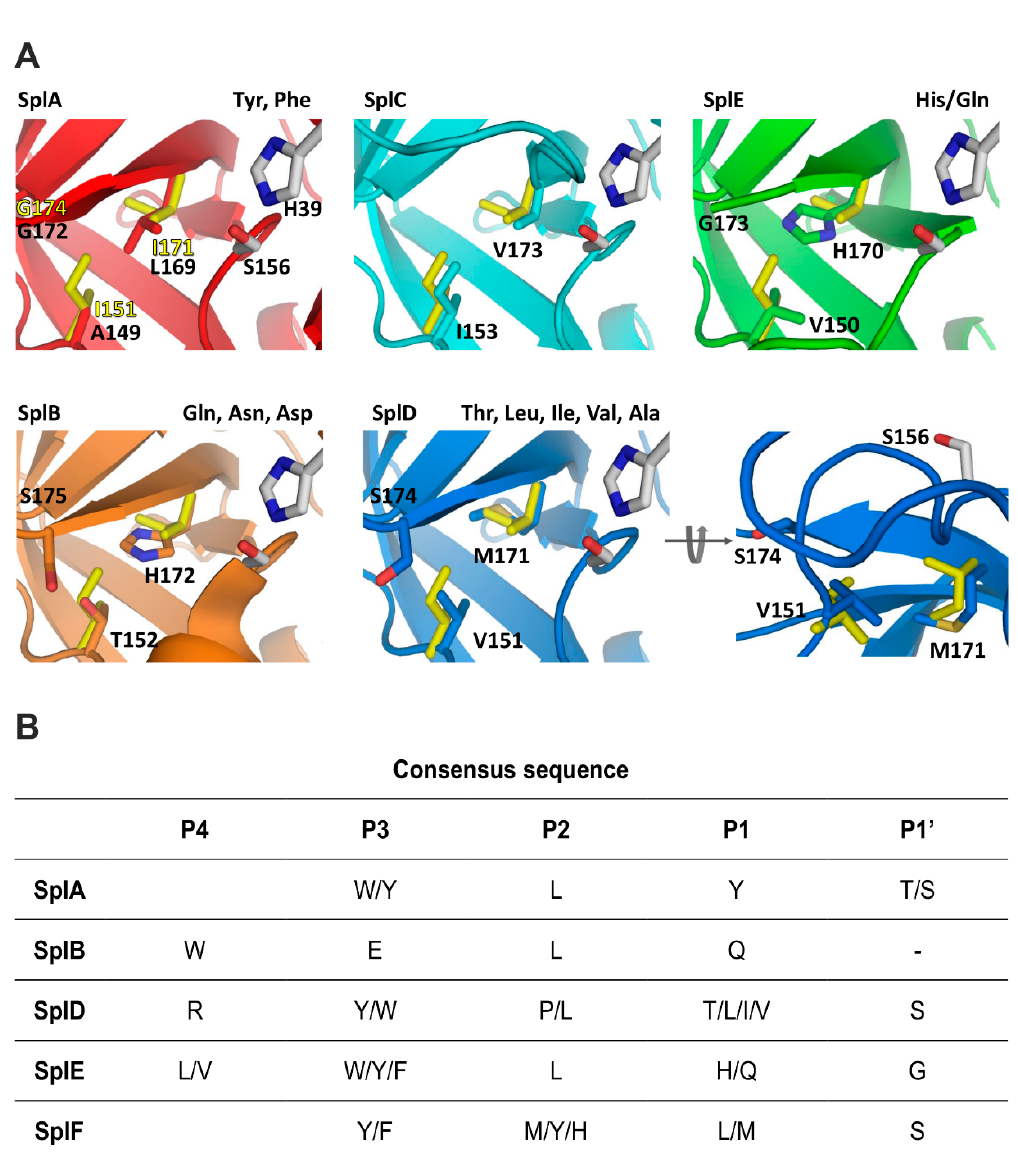
Figure 4. S1 specificity pockets of Spl proteases in the context of their substrate specificities. ( A ) The residues defining the S1 pocket of SplF (PDB 6SF7, yellow) are overlaid on relevant pockets of other proteases of the spl operon: SplA (PDB 2W7S, red) [13], SplB (PDB 2VID, orange) [14], SplC (PDB 2AS9, cyan) [17] and SplD (PDB 4INK, blue) [15] and SplE (PDB 5MM8, green) [16]. Catalytic triad residues are highlighted grey. Residues exposed at the S1 pocket and thus of direct significance in specificity determination are shown in stick model and colored according to the compared proteases. See Figure S4 for broader overview of the binding cleft in compared enzymes. ( B ) Consensus sequences recognized and cleaved by Spl proteases characterized to date.